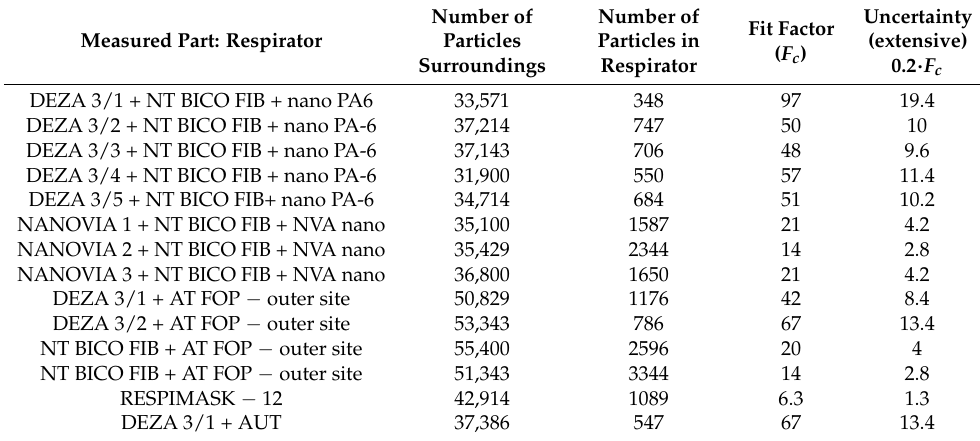
Table 4. Results of the assessment of the respirators made of different construction materials in terms of the so-called Fit factor ( Fc ).